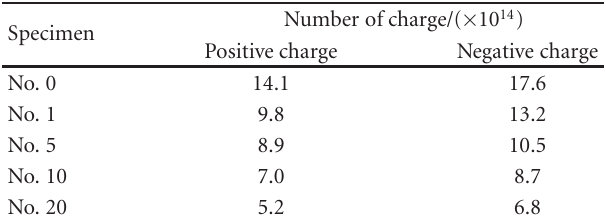
Table 2: Number of electronic charges per fast packet.